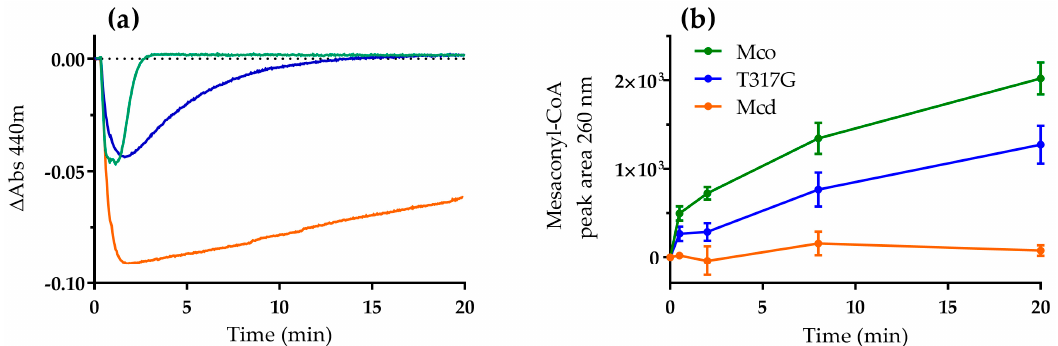
Figure 2. Reaction of Mcd (orange), T317G (blue) and Mco (green; 20 µM each) with dioxygen as electron acceptor. Reactions were started by the addition of ethylmalonyl-CoA (100 µM), which was converted in situ to (2 S )-methylsuccinyl-CoA by ethylmalonyl-CoA mutase (0.5 µM). ( a ) The redox state of the enzyme-bound FAD was observed at 440 nm; and ( b ) product formation was analyzed by liquid chromatography (LC) with detection of mesaconyl-CoA at 260 nm. Error bars indicate the standard deviation of three assay replicates.